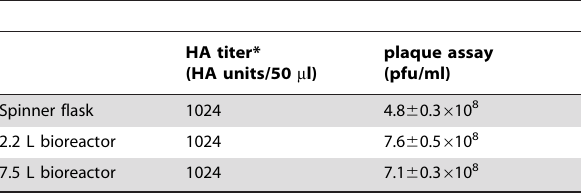
Table 1. Production of virus titers in various microcarrier/ bioreactor systems.